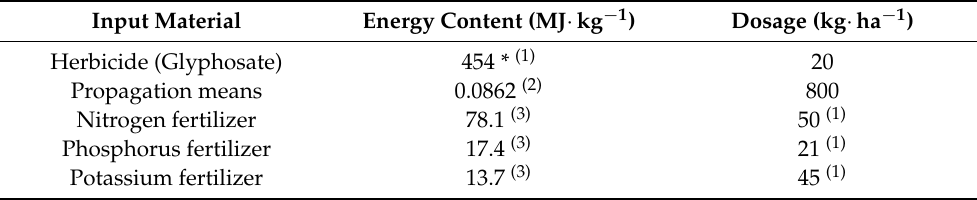
Table 3. Energy content per unit mass and dosage for the input materials.